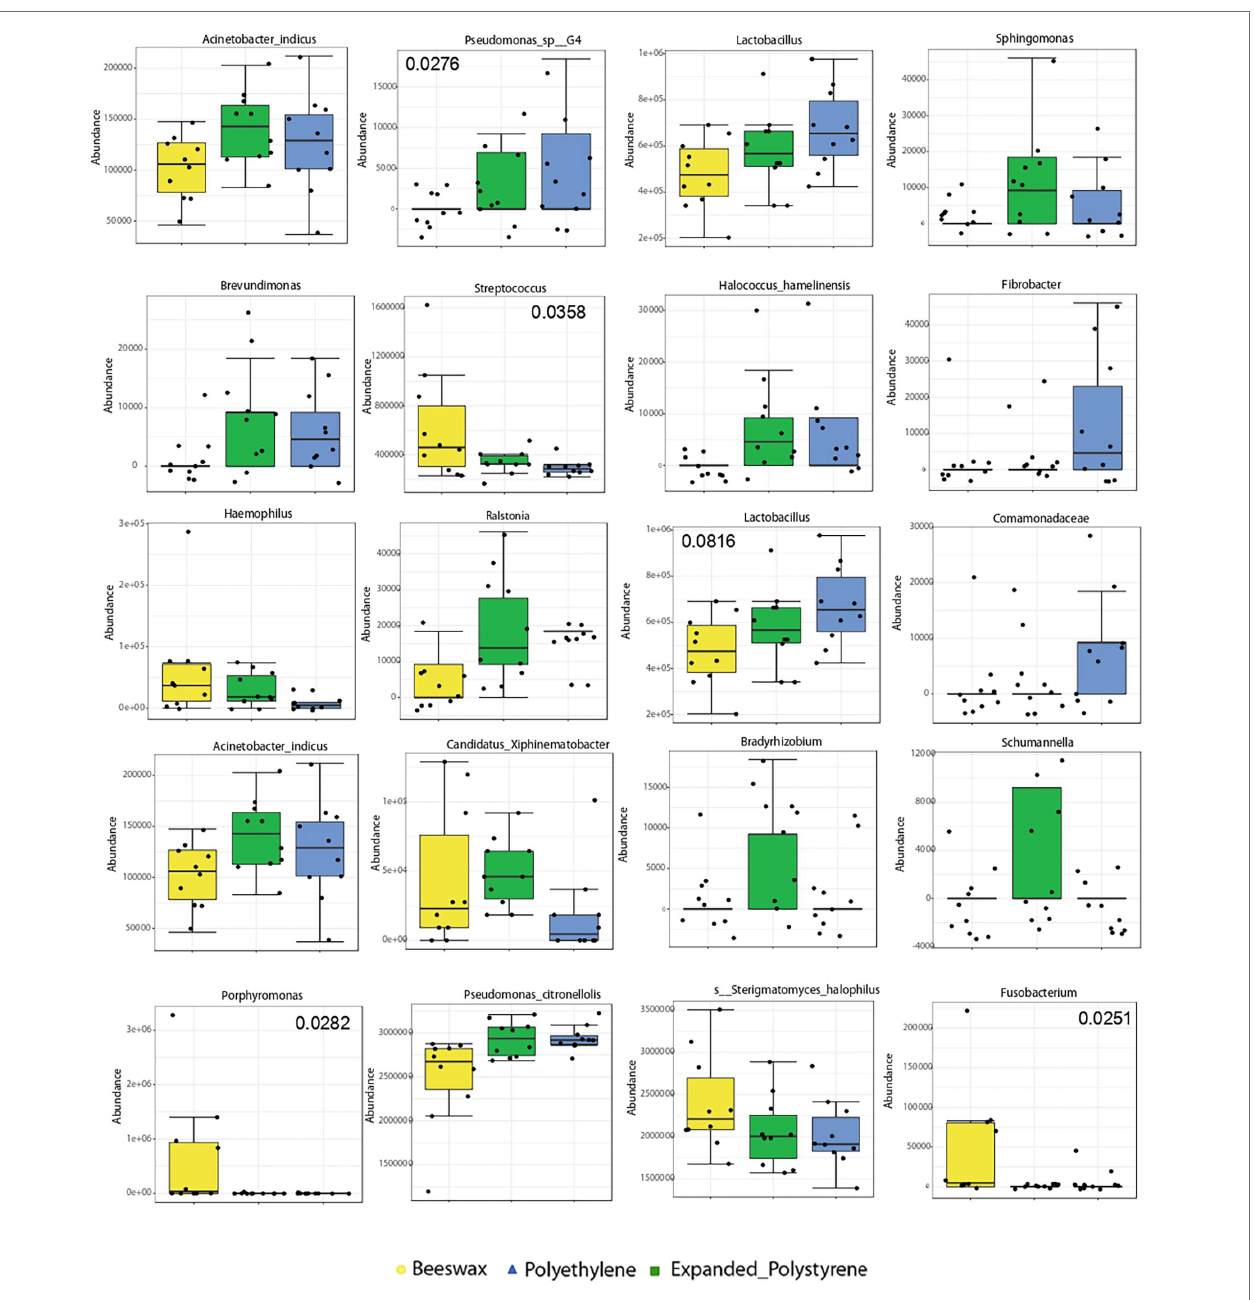
FIGURE 4 | Biomarker discriminant taxa analyses of bacterial communities according to the treatment, via LEfSe (Linear discriminant analysis Effect Size) algorithm, including only OTUs present in at least 50% of the samples. Values of p are in some taxa added to the